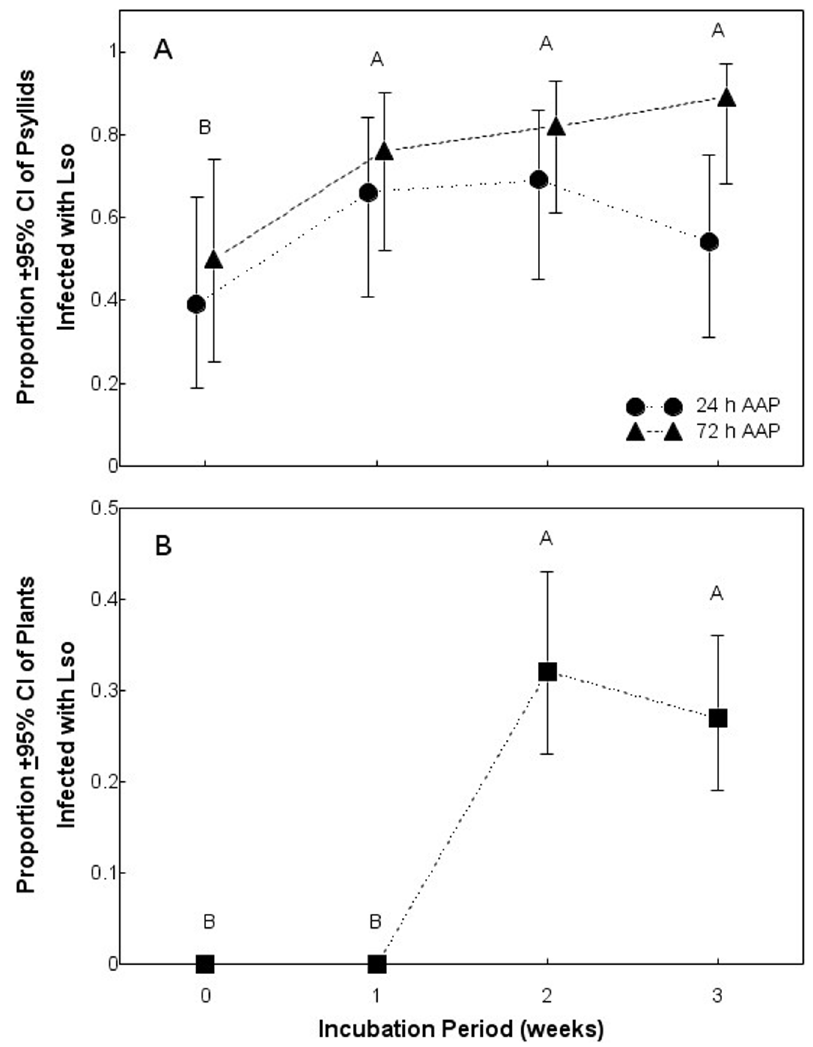
Figure 3. Proportion of potato psyllids (A) or plants (B) to test positive for Lso using quantitative real-time PCR. Different letters indicate significant differences among weeks, regardless of acquisition access period.